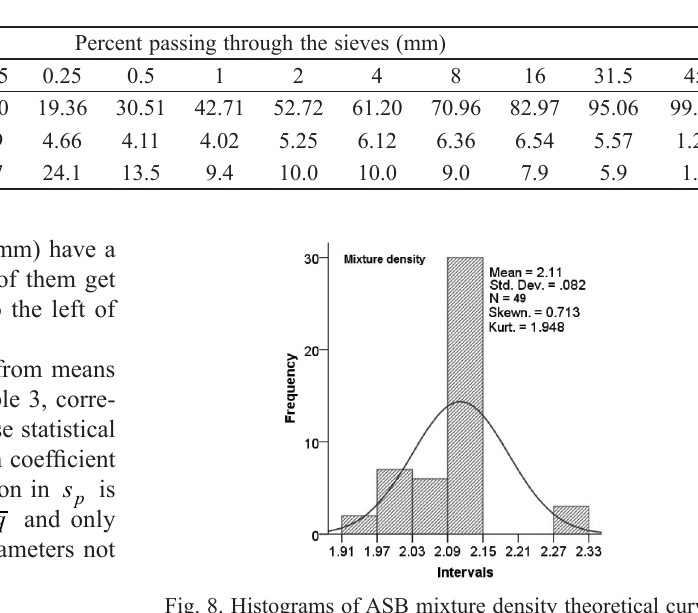
Table 3. Gradation variation in ASB mixture